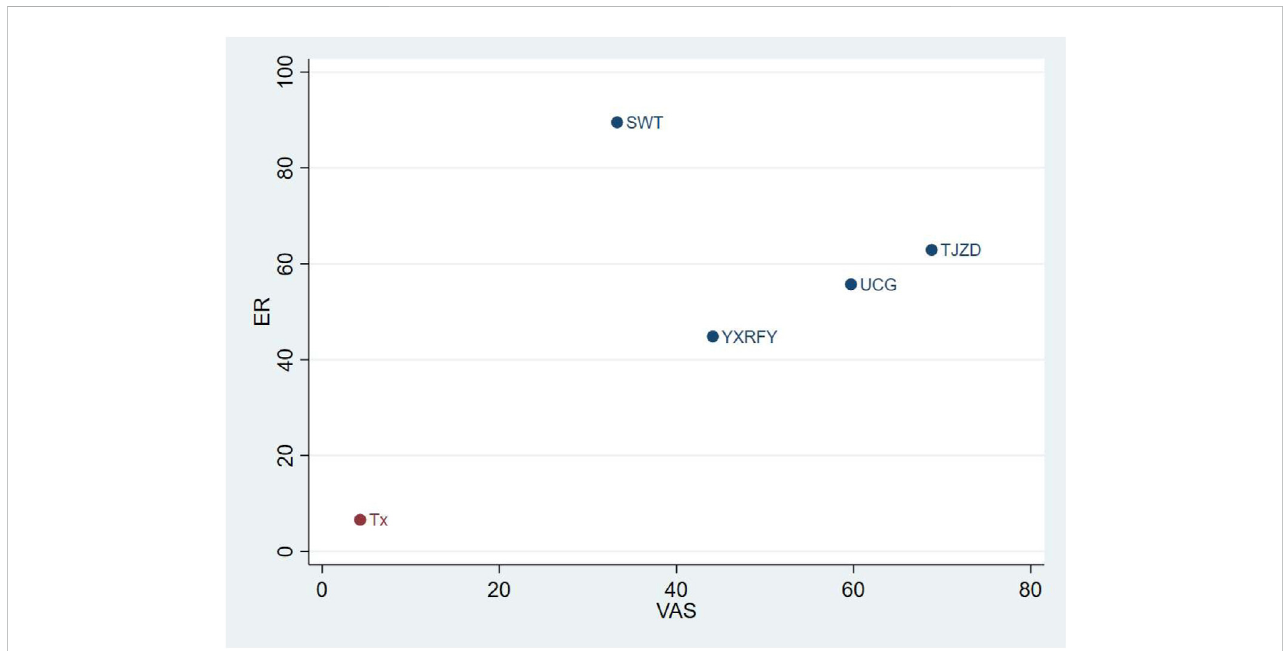
FIGURE 3 Cluster ranking plot. The cluster ranking plot is based on surface under the cumulative ranking curve (SUCRA) values. The vertical column indicates SUCRA values for the overall effective rate (ER); the horizontal column indicates SUCRA values for the visual analog scale (VAS). CHM treatments in the upper right corner improve the overall effective rate and visual analog scale more than the other